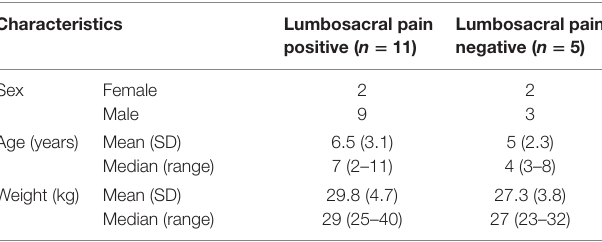
tABLe 1 | description of sample population of 16 Belgian malinois military working dogs included in the study.